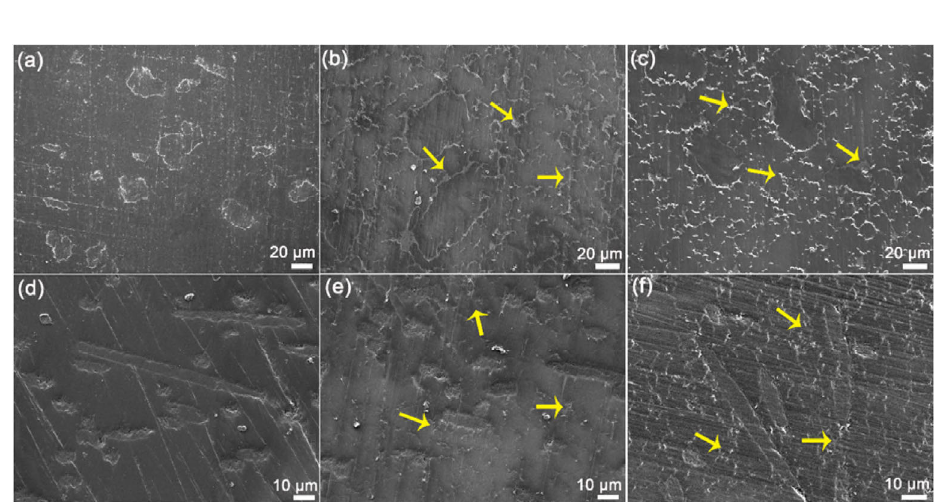
Fig. 2 SEM images of the distribution of various fillers in (a) PI/AP, (b) PI/AP/SiO 2 , (c) PI/AP/BN, (d) PI/SCF, (e) PI/SCF/SiO 2 , and (f) PI/SCF/BN. The nanoparticles in the composites are identified by the yellow